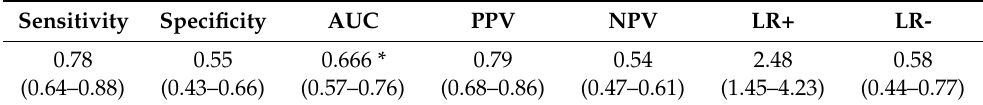
Table 4. Screening properties of the SUNFRAIL tool for cutoff